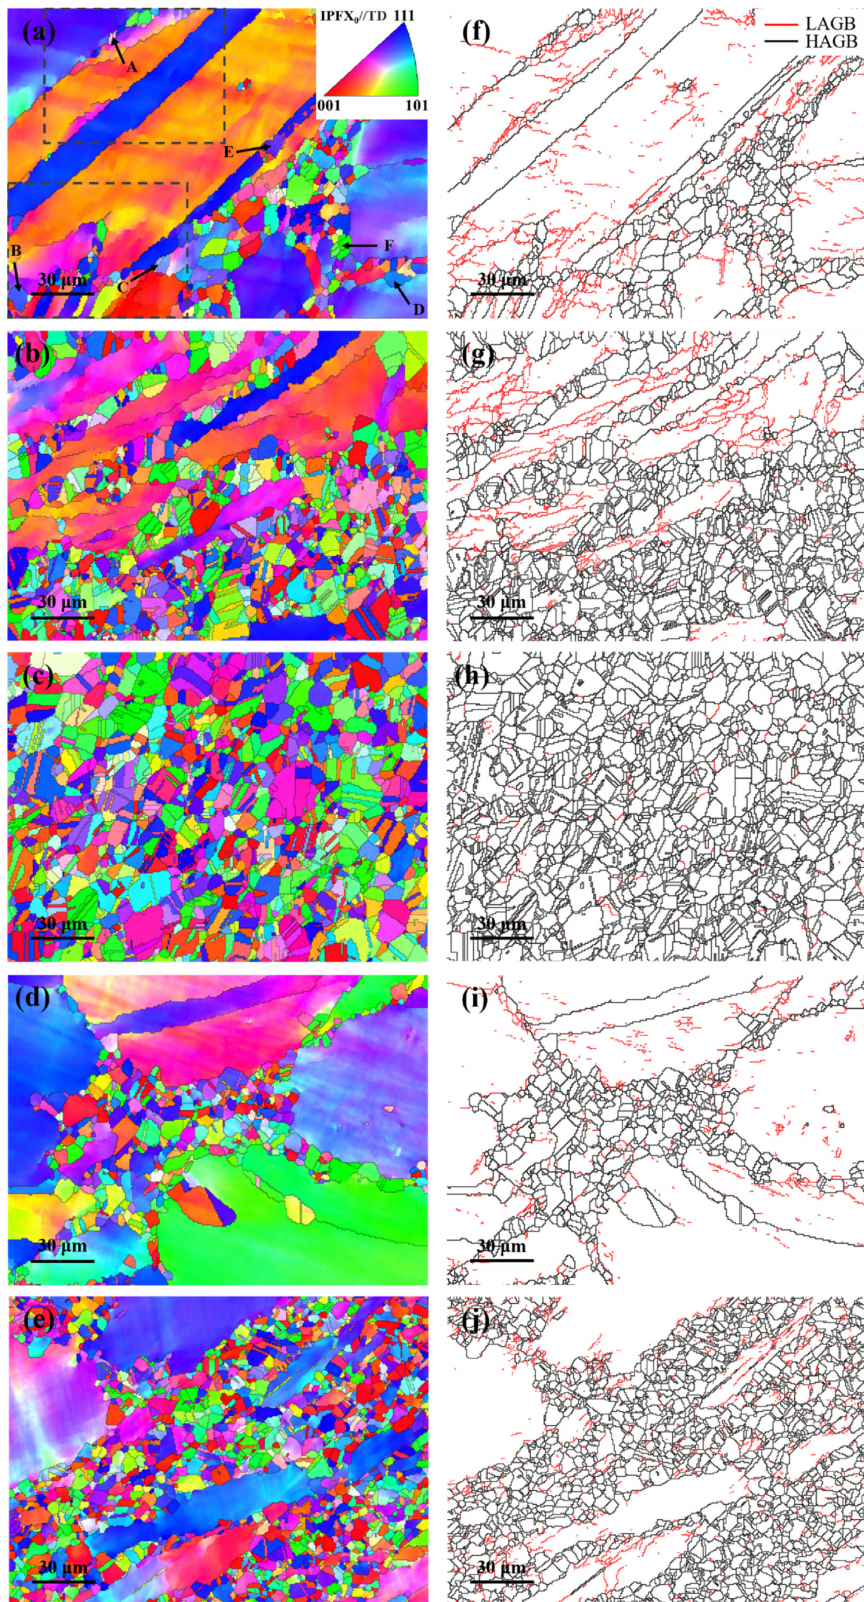
Figure 10. IPF maps and grain misorientations distribution of Inconel 625 under different hot- deformation conditions: ( a , f ) 1000 ◦ C, 0.05 s − 1 , ( b , g ) 1000 ◦ C, 0.01 s − 1 , ( c , h ) 1000 ◦ C, 0.005 s − 1 , ( d , i ) 950 ◦ C, 0.01 s − 1 , ( e , j ) 1050 ◦ C, 0.01 s − 1